Question: Summarize what this figure shows in one sentence.
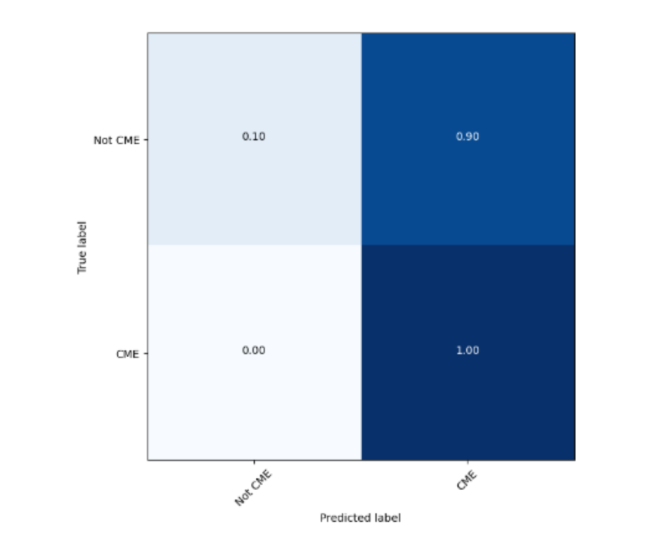
Answer: Confusion matrix visualizing model performance in predicting coronal mass ejection cases.